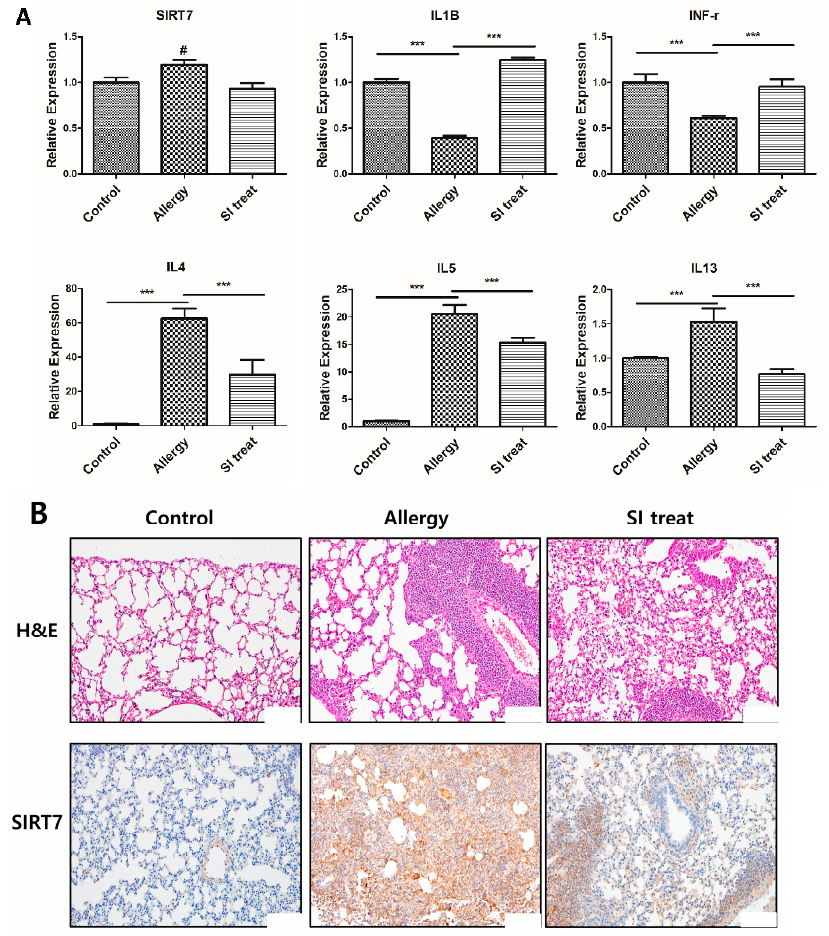
Figure 2. Expression of sirtuin (SIRT)7 and inflammatory cytokines in lung tissues of the ovalbumin (OVA)-induced inflammation murine model. SIRT7 inhibition attenuated OVA-induced allergic inflammation of the lung. ( A ) Comparison of SIRT7 and inflammatory cytokine expression between the control group, allergic inflammation group, and SIRT7 inhibitor (SI)-treated group with qRT-PCR. ( B ) Hematoxylin and eosin staining of lung tissues of the control group, allergic inflammation group, and SI-treated group. Immunohistochemical staining of SIRT7 in lung tissues of the control group, inflammation group, and SI-treated group. Error bars indicate the mean ± standard error of the mean. # p = 0.065, *** p < 0.05. White scale bar = 50 μ m.